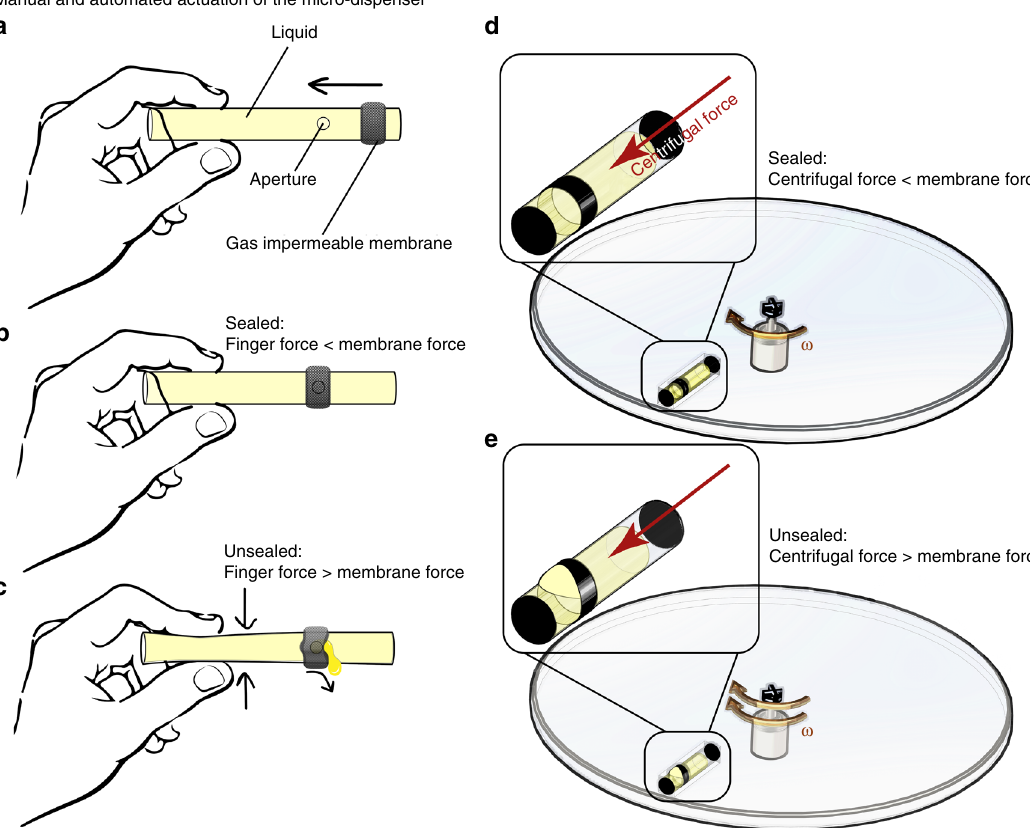
Fig. 6 Schematic illustration of the micro-dispenser technology (two con fi gurations). Panels ( a ) and ( b ) show the micro-dispenser components and assembly, panel ( c ) shows manual actuation by pressing the micro-dispenser body. Panel ( d ) shows the micro-dispenser inserted in a lab-on-a-disc platform, when the centrifugal pressure is lower than membrane resistance, panel ( e ) by increasing the spinning speed, centrifugal force stretches the membrane that allows a temporary release of liquid. The micro-dispenser size is exaggerated for